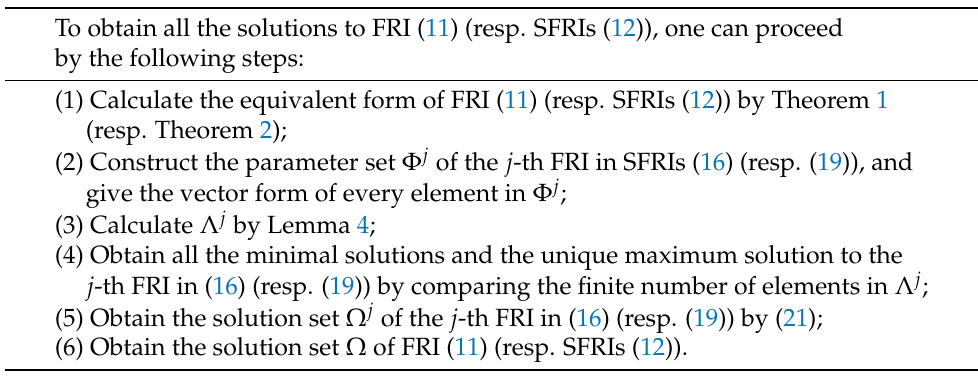
Table 1. Procedure on the resolution of FRI (11) and SFRIs (12).